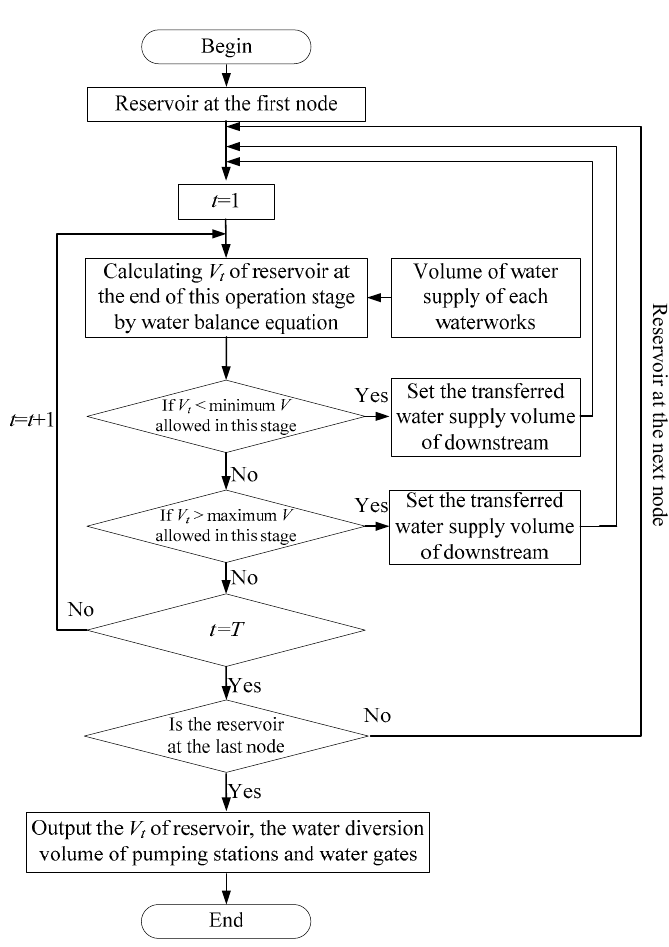
Figure 7. The core calculation flowchart of the reverse calculation mode.